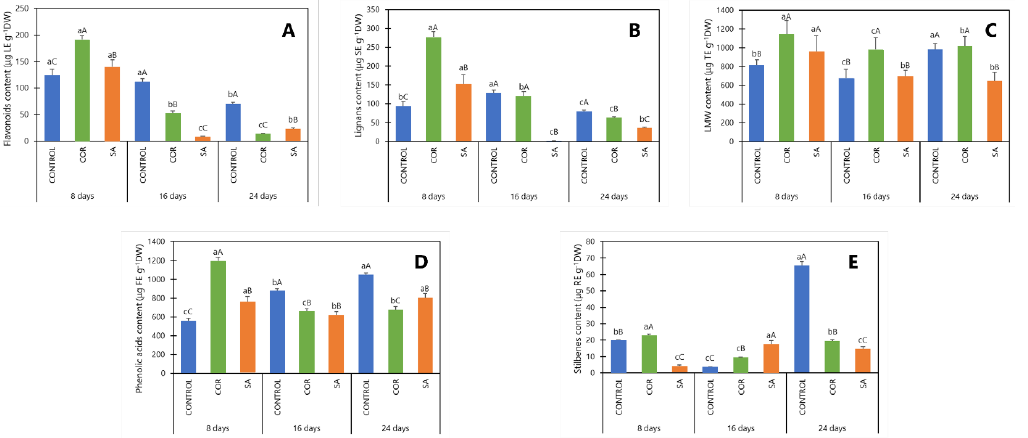
Figure 4. Semi − quantification of phenolic families in the extracts from T. baccata cell suspensions either untreated (control) or elicited with 1 μM coronatine (COR) or 150 μM salicylic acid (SA) at all the experimental time points (days 8, 16, and 24). ( A ) Flavonoid content expressed as μg of luteolin equivalents per gram of dry weight (μg LE/gDW). ( B ) Lignan content expressed as μg of sesamin equivalents per gram of dry weight (μg SE/gDW). ( C ) Low − molecular − weight polyphenol content expressed as μg of tyrosol equivalents per gram of dry weight (μg TE/gDW). ( D ) Phenolic acid con- tent expressed as μg of ferulic acid equivalents per gram of dry weight (μg FE/gDW). ( E ) Stilbene content expressed as μg of trans − resveratrol equivalents per gram of dry weight (μg RE/gDW). Ver- tical bars indicate standard deviation (n = 6). Lowercase letters indicate significant differences ( p < 0.05) within the same treatment between experimental time points. Capital letters indicate signifi- cant differences ( p < 0.05) between treatments within the same experimental time point. The statis- tical differences were evaluated according to Tukey’s test. Considering the combination of all phenolic families, the maximum total phenolic content (TPC) (Figure 5) was achieved at day 8 in COR − elicited samples (almost 3000 μg/g DW), which was 2 − fold and 1.5 − fold higher compared to control and SA-elicited samples, respectively. However, at day 16, the TPC of COR samples was similar to that of control cultures, having undergone a 1.5 − fold reduction. In the same way, SA-elicited samples also showed a decrease in TPC over time ( ~ 1343 μg/g DW at day 16). Surprisingly, the second highest TPC of the whole experiment ( ~ 2243 μg/g DW) was observed in control conditions at day 24, being 1.25 − fold and 1.47-fold higher than in COR- and SA − elicited samples, respectively.